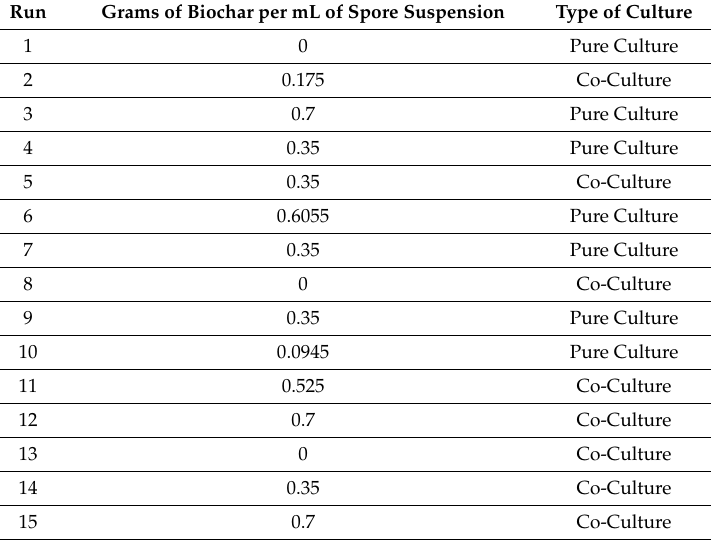
Table A1. Experimental design for the two-factor test.